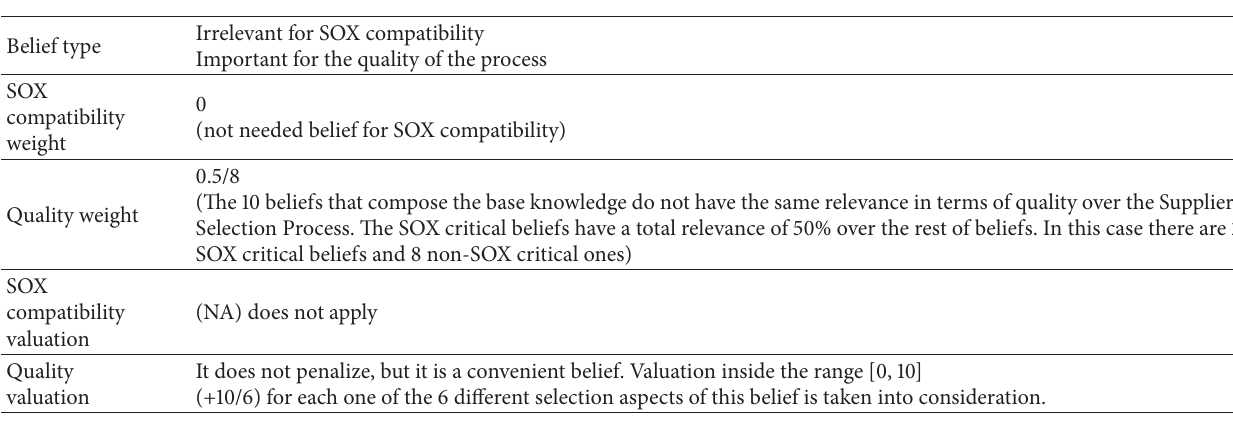
Table 9: Level of Prices Scoring Protocol.